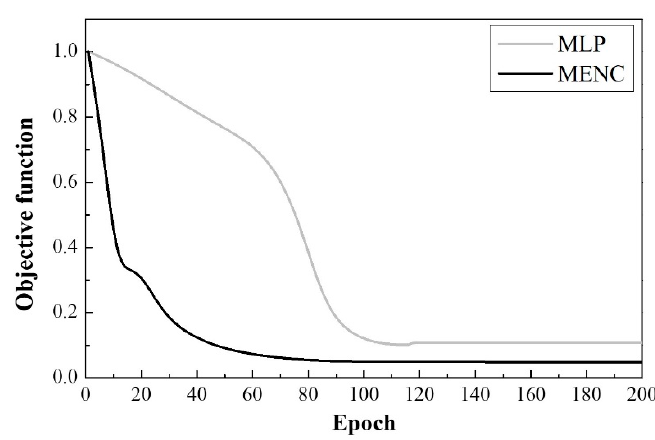
Figure 4. History of objective functions during training.